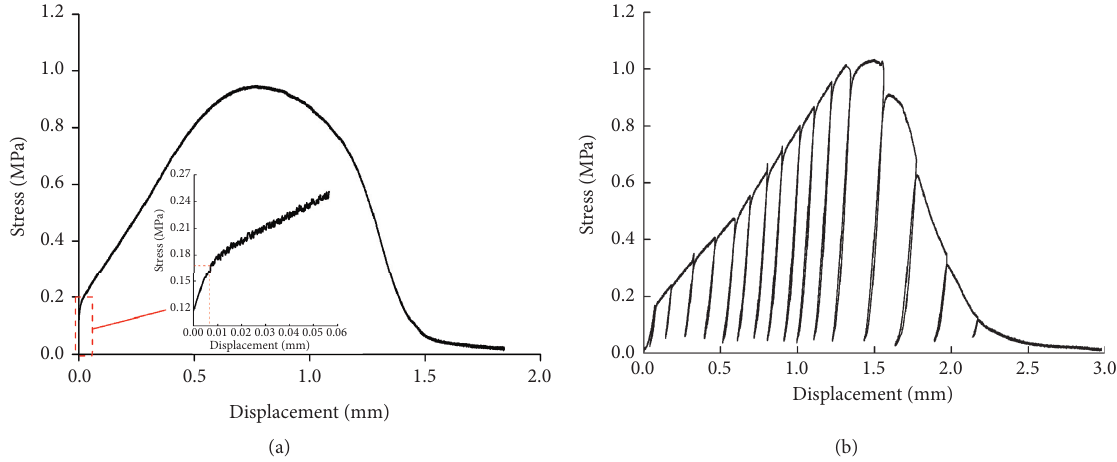
Figure 3: Stress-displacement curves of salt rock specimens. (a) Specimen d-1; (b) specimen f-1.